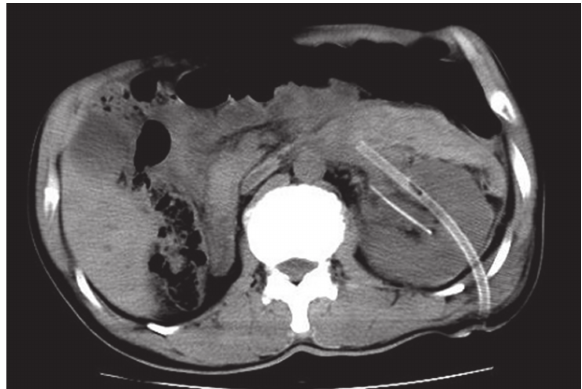
figure 3 - Computed tomography showing the nephrostomy tube piercing the renal parenchyma into the left renal